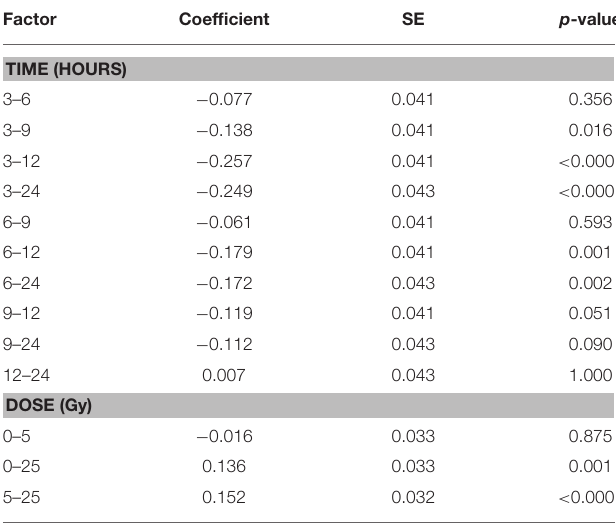
TABLE 1 | Differences from Tukey’s all-pair comparison of means shown for protein content of E. magnus for time after exposure and